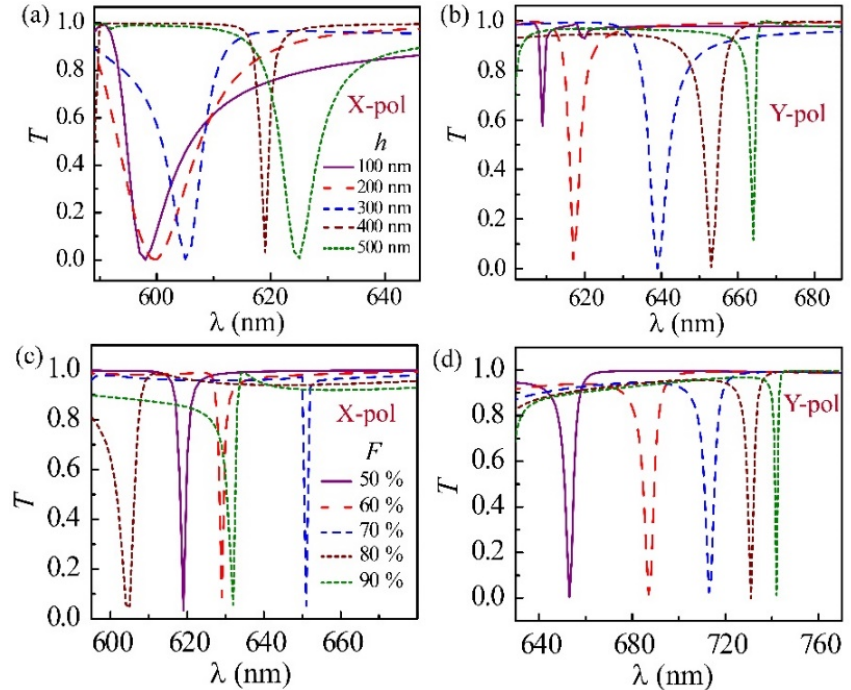
Figure 2. Optical responses of grating optimization. ( a , b ) show the variation in T with the λ for different h at normal incidence of X-pol and Y-pol lights, respectively, ( c , d ) show the variation in T with the λ for different F at normal incidence of X-pol and Y-pol lights, respectively.